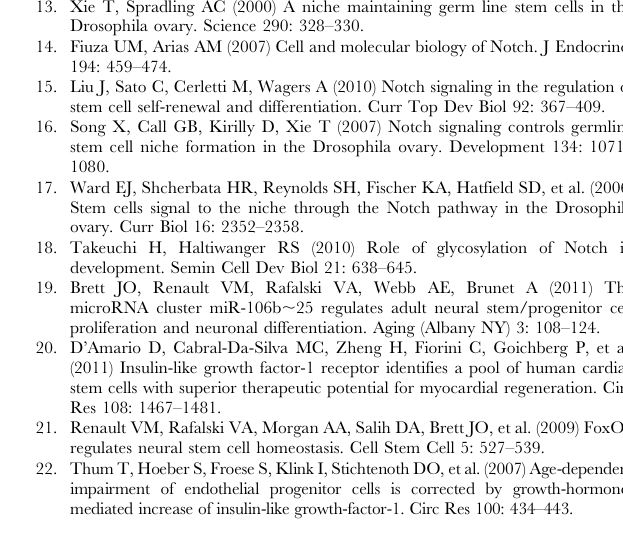
S1 Table Notch signaling controls GSC competition for niche occupancy via